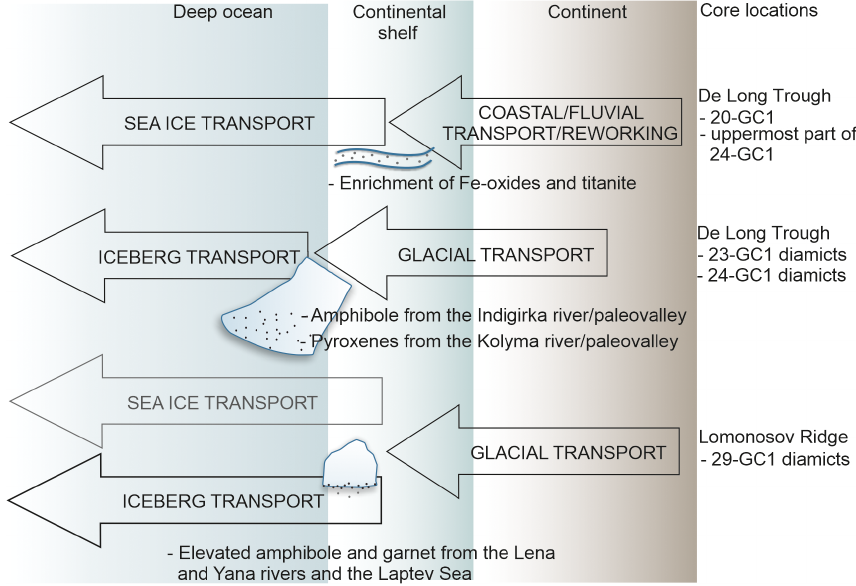
Figure 7. Synthesis of the heavy mineral analysis and interpretations of this study related to transportation and depositional sites.